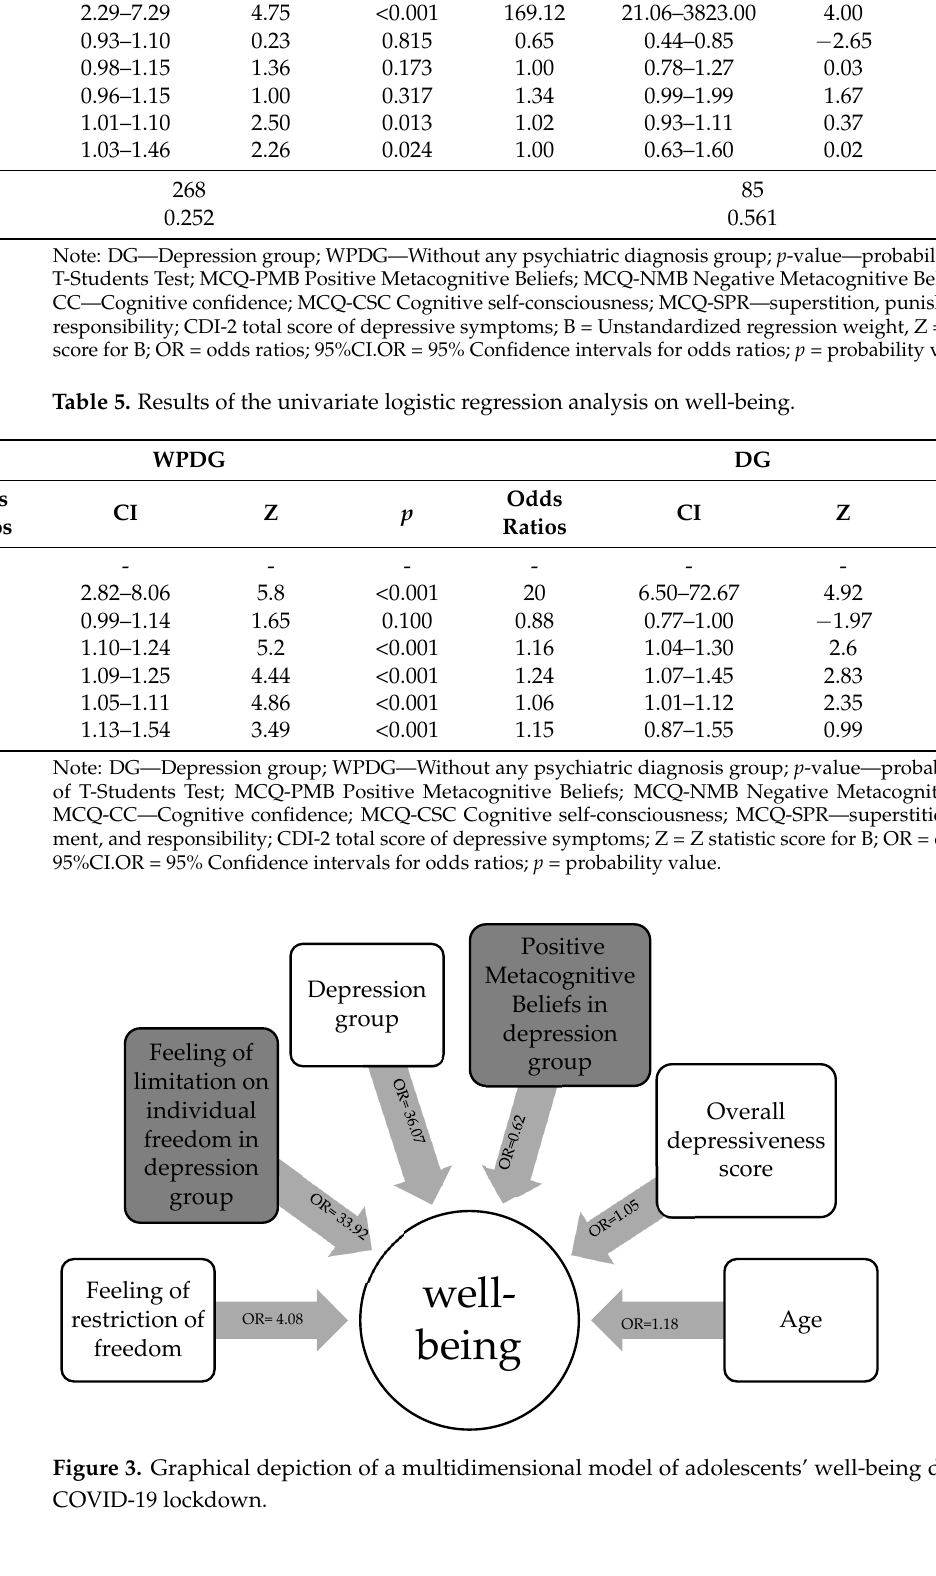
Table 4. Results of the multivariate logistic regression of simple effects of interaction for the WPDG and DG on well-being.